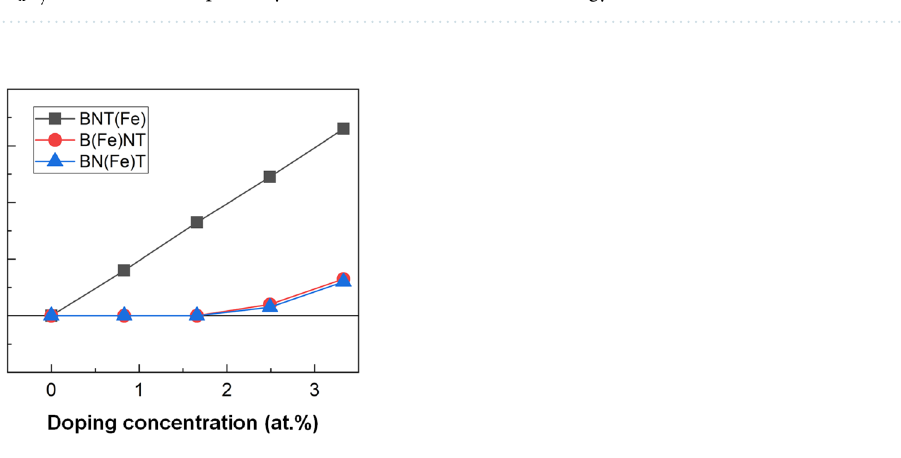
Figure 11. The DFT results of the d -orbital decomposed PDOS of the Fe substitutional atom for the (a) BNT(Fe), (b) B(Fe)NT, and (c) BN(Fe)T. The black, orange, red, green, and blue lines represent the d xy , d yz , d z2 , d xz , and d x2 –y2 orbital states, respectively. The Fermi level is set to zero energy.